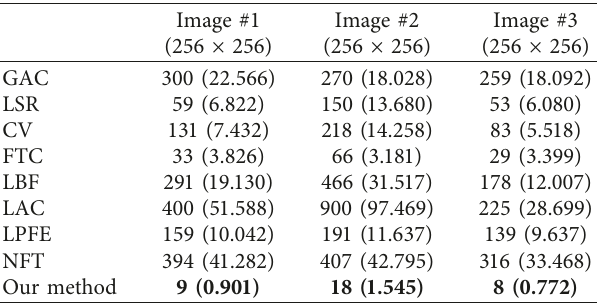
Table 4: Comparison of convergence rate metrics for the images in Figure 7 in the same order. The description format of the metrics is given as iteration number (CPU time